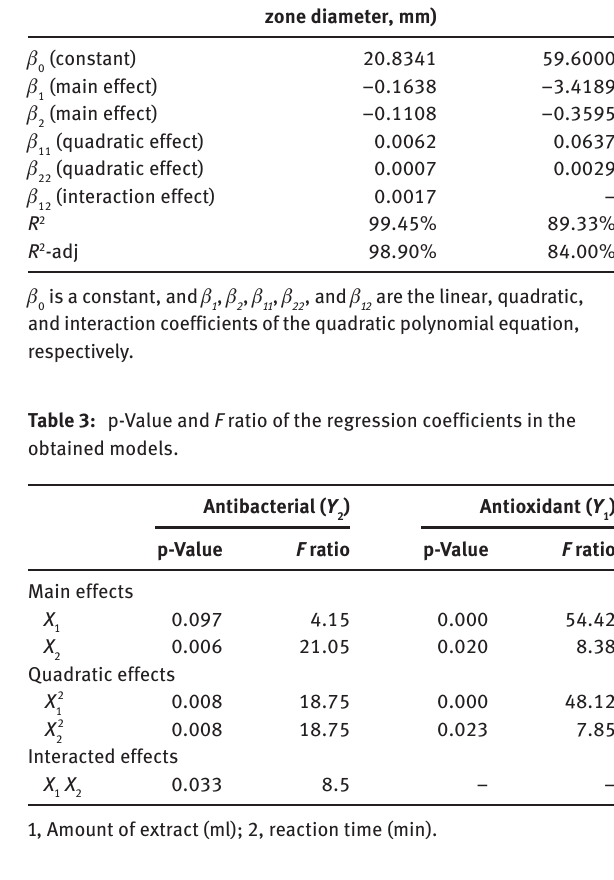
Table 2: Regression coefficients, R 2 , R 2 -adj, and probability values for the fitted models. Regression coefficient